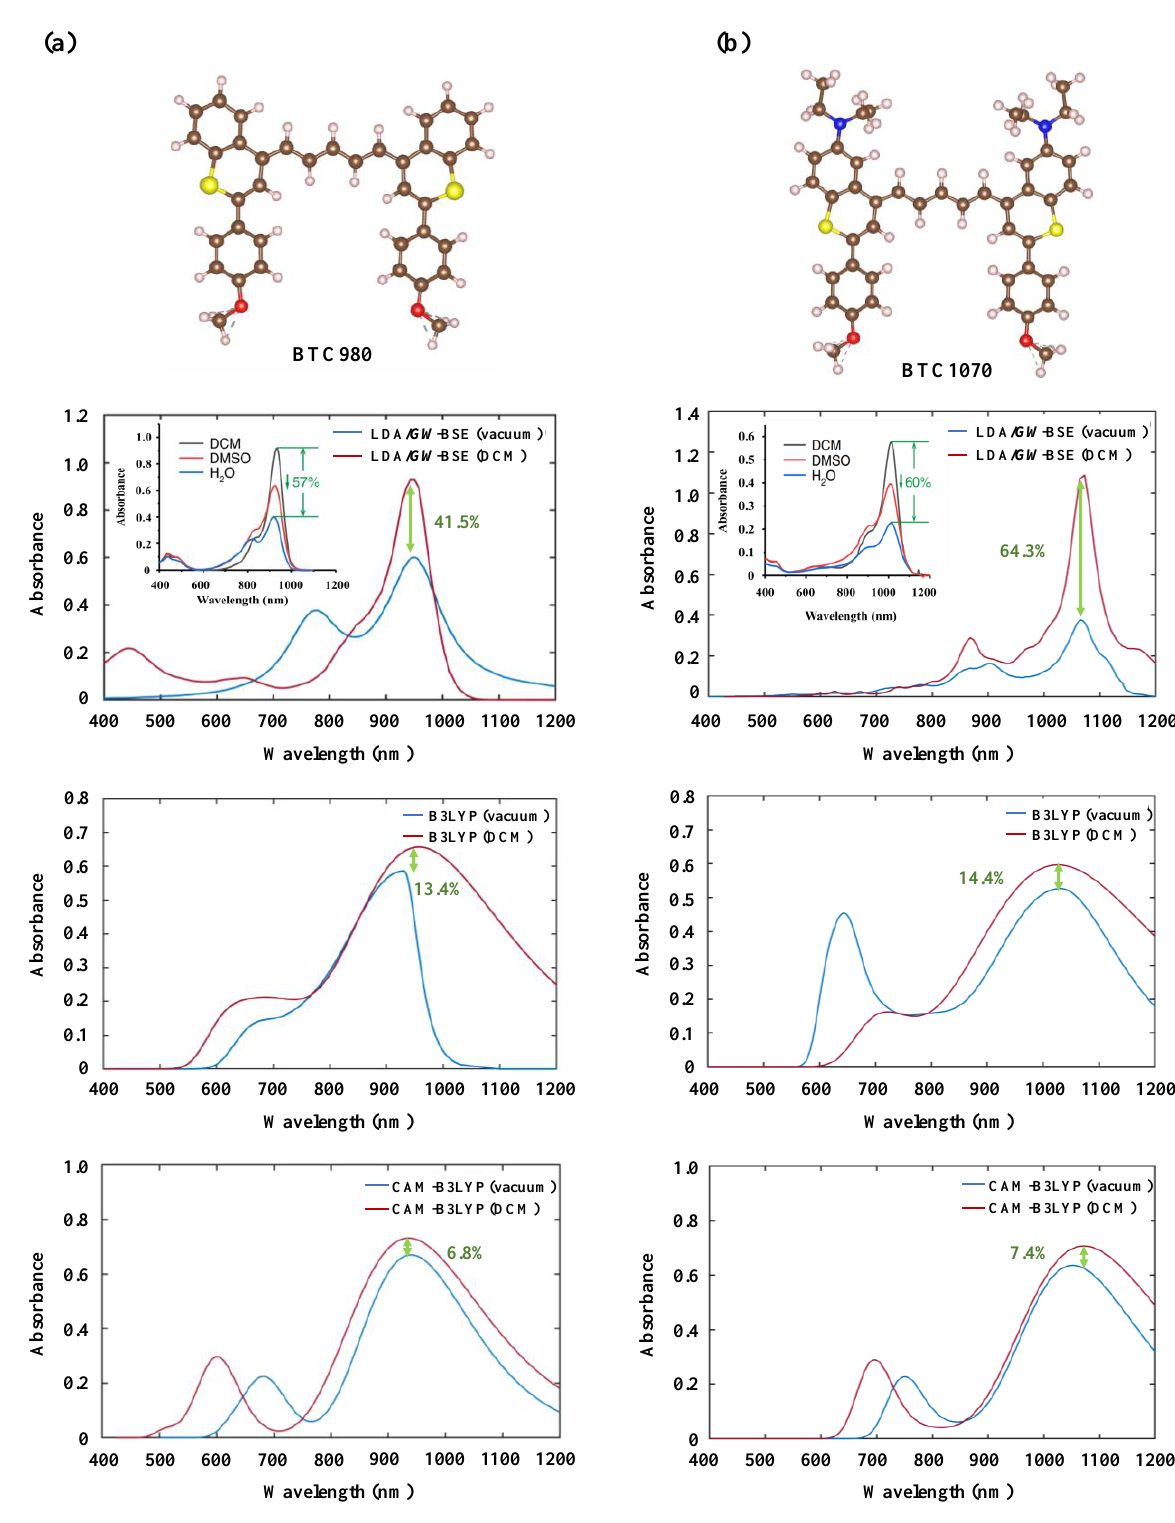
Figure 3. The UV-VIS absorption spectra of ( a ) BTC980 and ( b ) BTC1070 were simulated under GW -BSE, B3LYP, and CAM-B3LYP in vacuum and dichloromethane (DCM) solution. The inset figure is the UV-VIS spectra from the experiment [19].